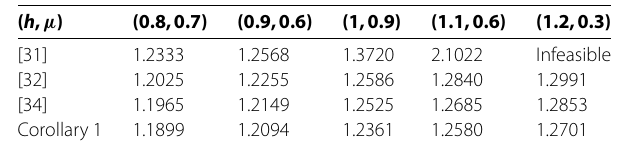
Table 2 The H ∞ performance index γ with different ( h , μ